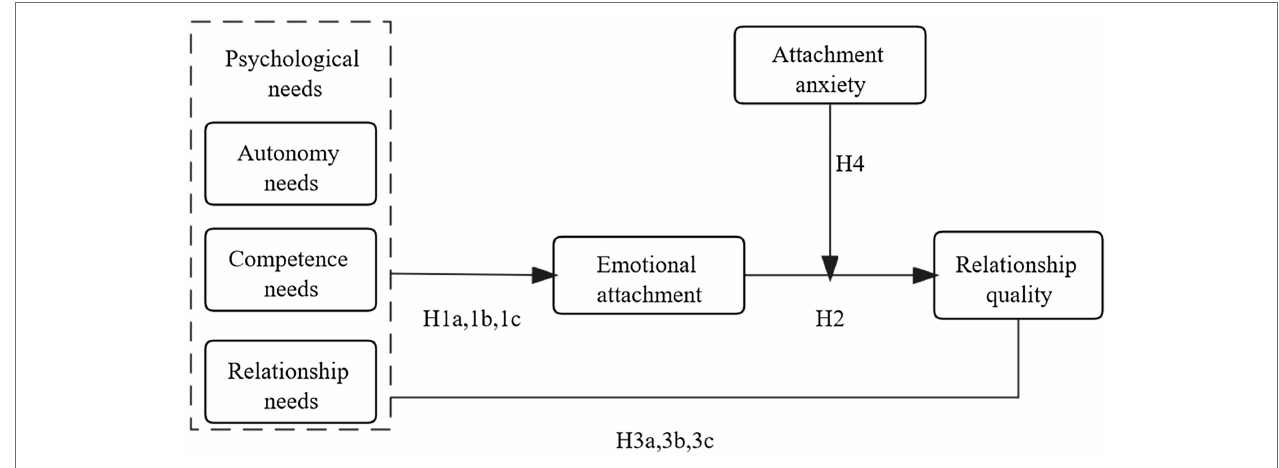
FIGURE 1 | Theoretical